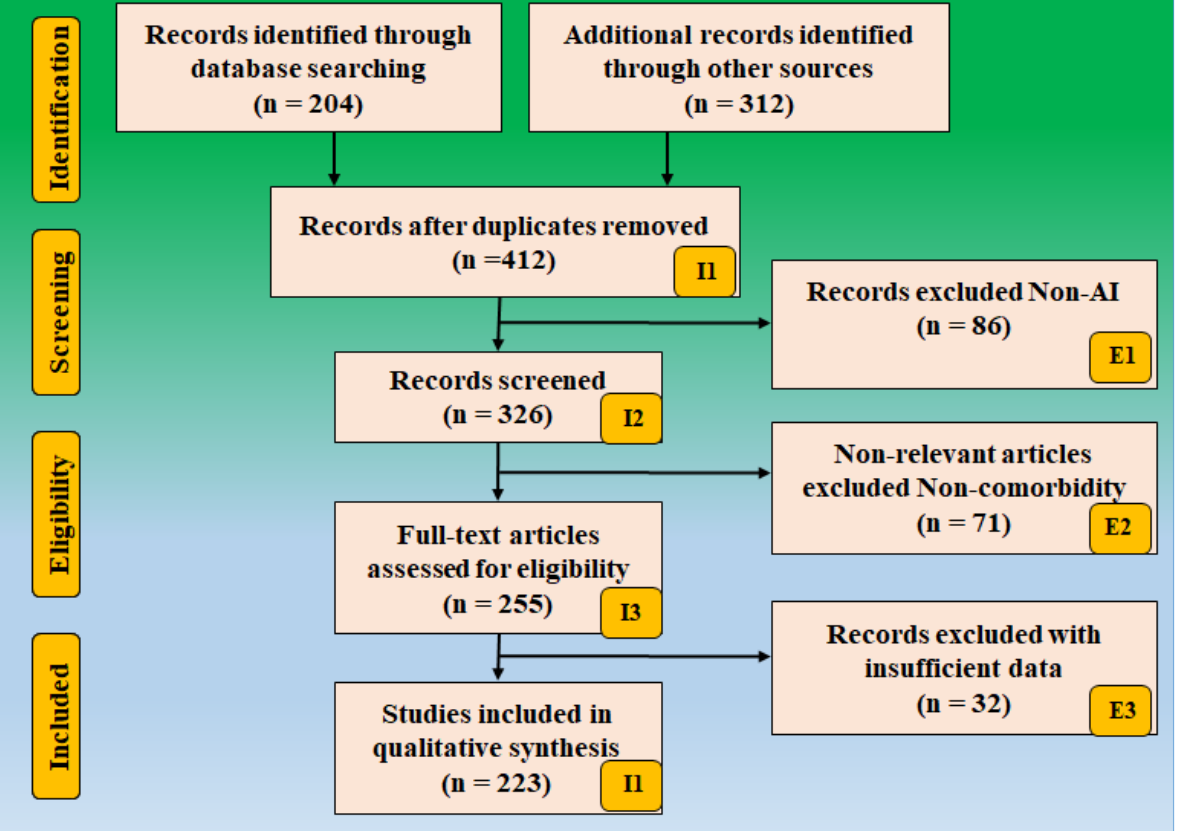
Figure 2. Search strategy based on the PRISMA model.